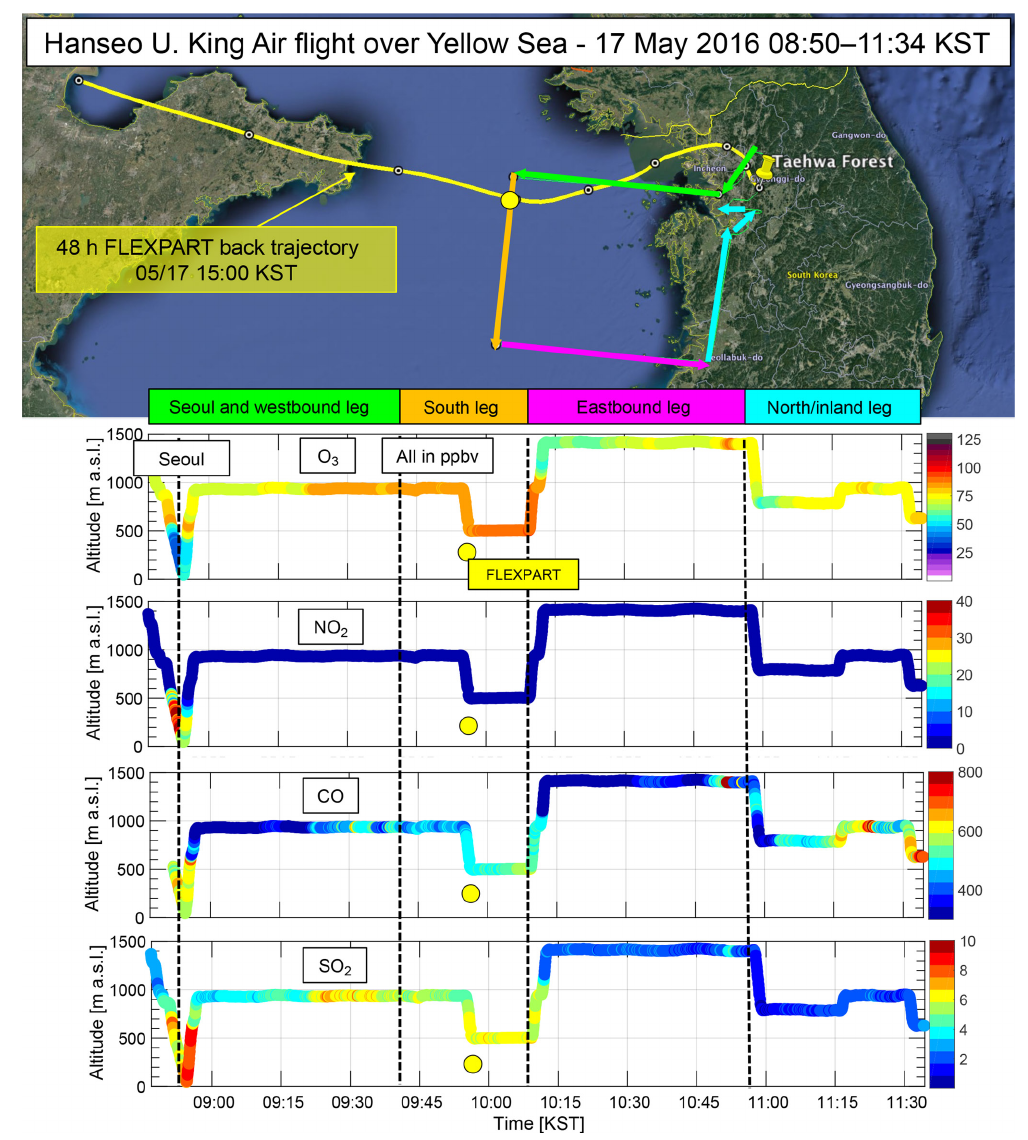
Figure 5. Hanseo University King Air Flight on 17 May 2016 to sample O 3 , NO 2 , CO, and SO 2 over South Korea and the Yellow Sea